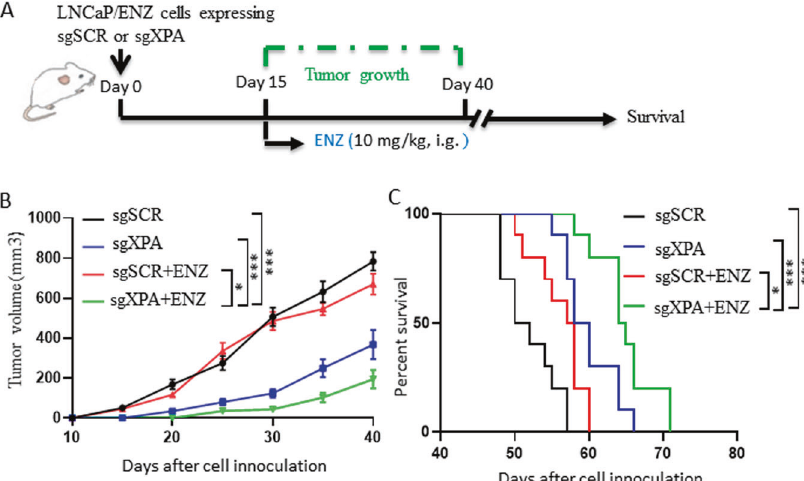
Fig. 6 XPA knockout combats the enzalutamide resistance. A – C LNCaP/ENZ cells (1 × 10 6 ) were infected with lentivirus expressing sgSCR and sgXPA and then injected subcutaneously into the fl ank of 8-week-old male castrated mull mice. When tumor size reached ~50 mm 3 , mice were administered with the vehicle (10% DMSO plus 90% corn oil mixture as control, n = 10), ENZ (10 mg/kg, i.g.) ( A ). Tumor volume ( n = 10) ( B ) and survival ( n = 10) ( C ) were monitored as indicated days. Data are presented as means ± s.e.m. Statistical analysis for tumor growth and overall animal survival were performed using two-way ANOVA analysis ( B ) and Log-rank (Mantel-Cox) test analysis ( C ), respectively. The asterisks indicate signi fi cant differences between the indicated groups (* p < 0.05, *** p <